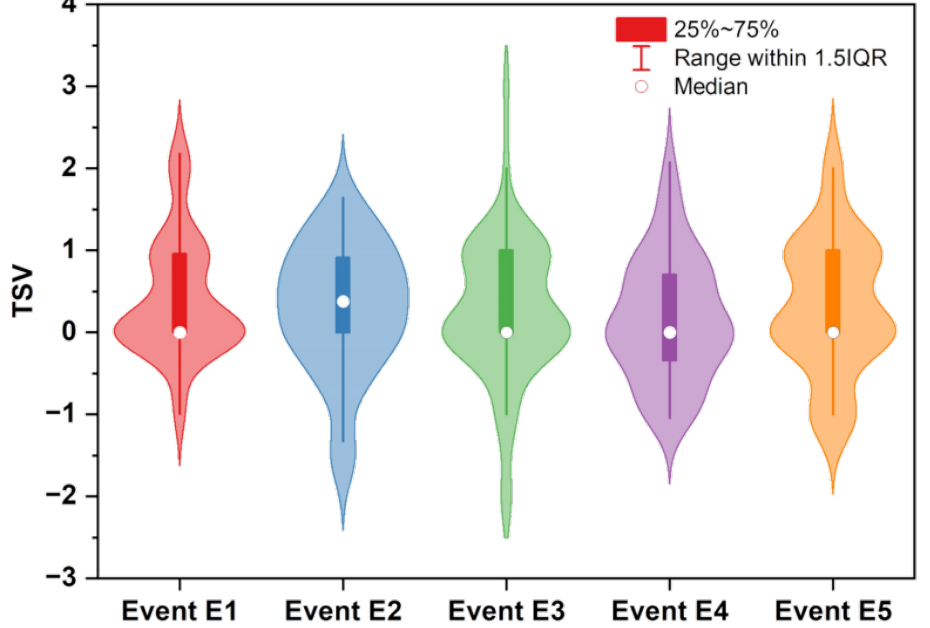
Figure 6. Average recorded TSVs for each event. n = 53 cases. The average transient variation of SKT, EBT, and TSVs of the participants along the duration of the experiment is shown in Figure 7. EBT is sinusoidal in nature and increases during exhalation and decreases during inhalation. The average EBT and SKT in the transition period from P5 to P6 increased because of their previous thermal experiences and were more controlled in the closed train cabin than in the semi-controlled platform or exit. This observation was reinforced by their TSVs during P5 to P6, as shown in Figure 7c. The average TSV increased while leaving the train and heading toward the platform and exit, which may have affected the increased